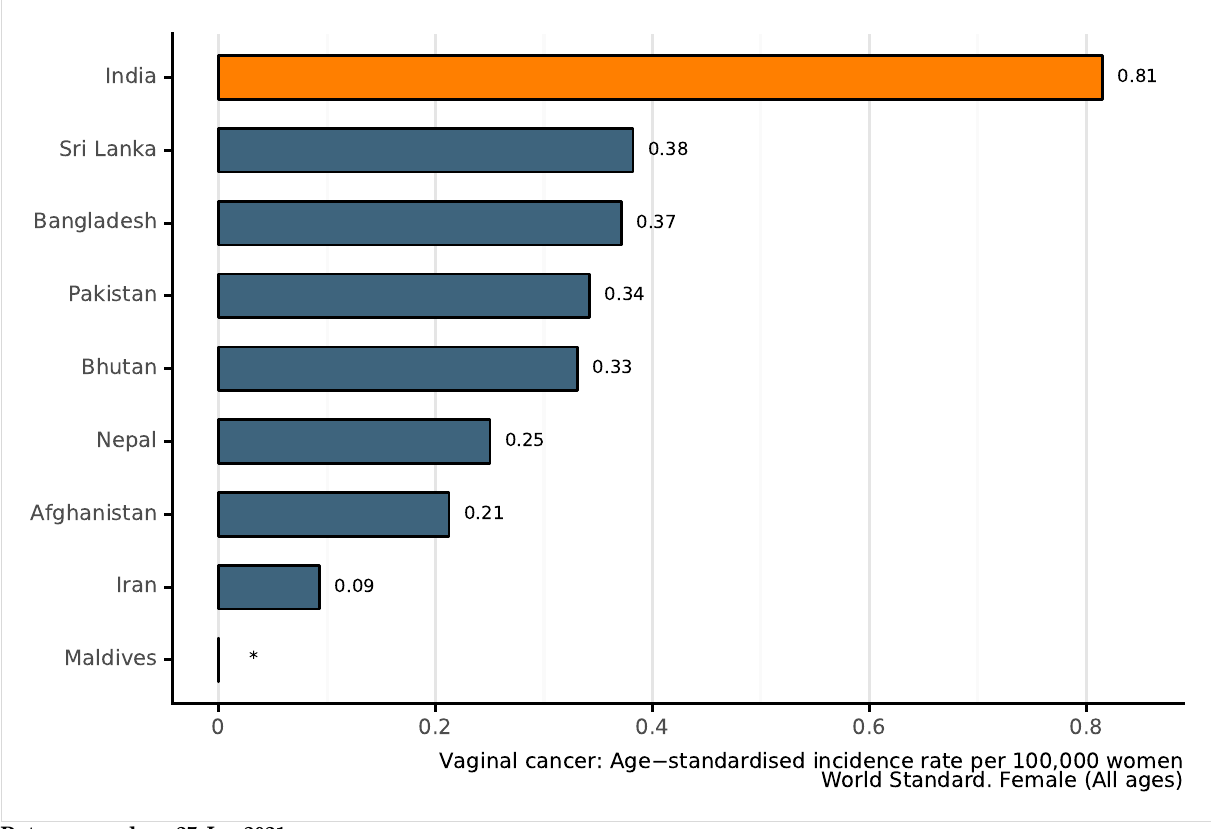
Figure 84: Age-standardised incidence rates of vaginal cancer of India (estimates for 2020)